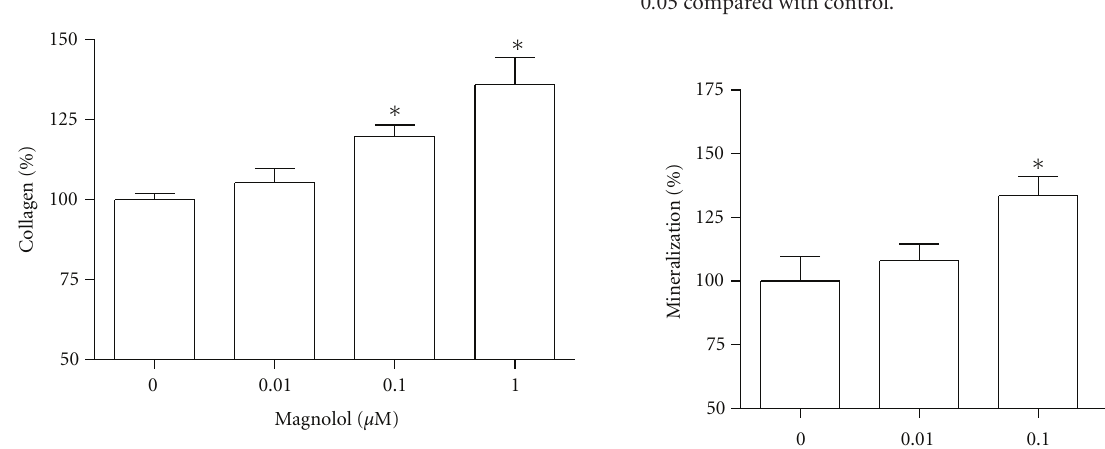
Figure 2: E ff ect of magnolol on the collagen synthesis of MC3T3- E1 cells. Data were expressed as a percentage of control. The control value for collagen content was 23.45 ± 0.659 μ g/10 6 cells. ∗ P < 0 . 05 compared with control.